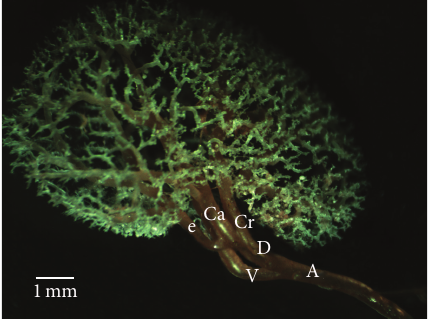
Figure 6: Dorsocaudal view of the intrarenal branches of the renal arteries, Type II. A: renal artery; V: the ventral branch of renal artery; D: the dorsal branch of renal artery; Cr: the cranial division of the renal artery; Ca: the caudal division of the renal artery; e: extrainterlobar branch from the renal artery for the opposite